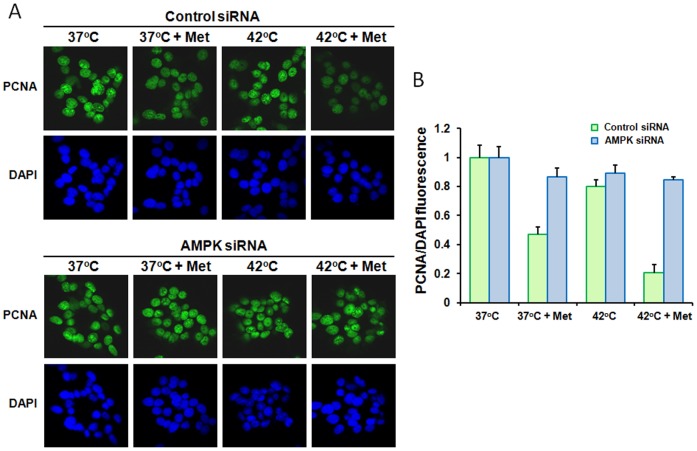
Cell proliferation was studied with immunostaining for PCNA and DAPI in MCF-7 cells.(A) Cells transfected with AMPK siRNA or control siRNA were incubated for 48 h at 37°C with or without 5 mM metformin. The effect of heating at 42°C for the first 1 h of 48 h incubation with or without 5 mM metformin was also studied. Following treatments, cells were immunostained for PCNA and DAPI, and the immunofluorescence intensity of PCNA and DAPI was determined with immunofluorescence microscopy. (B) Ratio of PCNA/DAPI fluorescence intensity observed in A. Means of 5 experiments ±1 S.E. is shown. The decrease in PCNA/DAPI fluorescence intensity by metformin was statistically significant at both 37°C and 42°C, and siRNA transfection significantly reduced the effect of metformin to decrease the PCNA/DAPI fluorescence intensity.